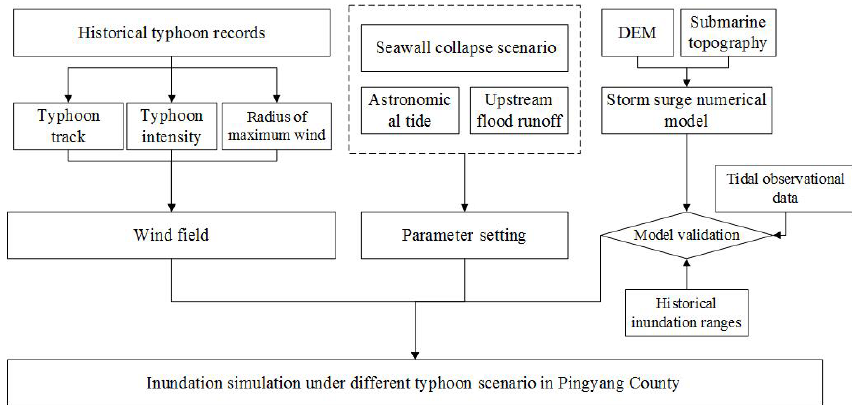
Figure 2. Framework of storm surge inundation simulation under different typhoon scenarios in Pingyang County.